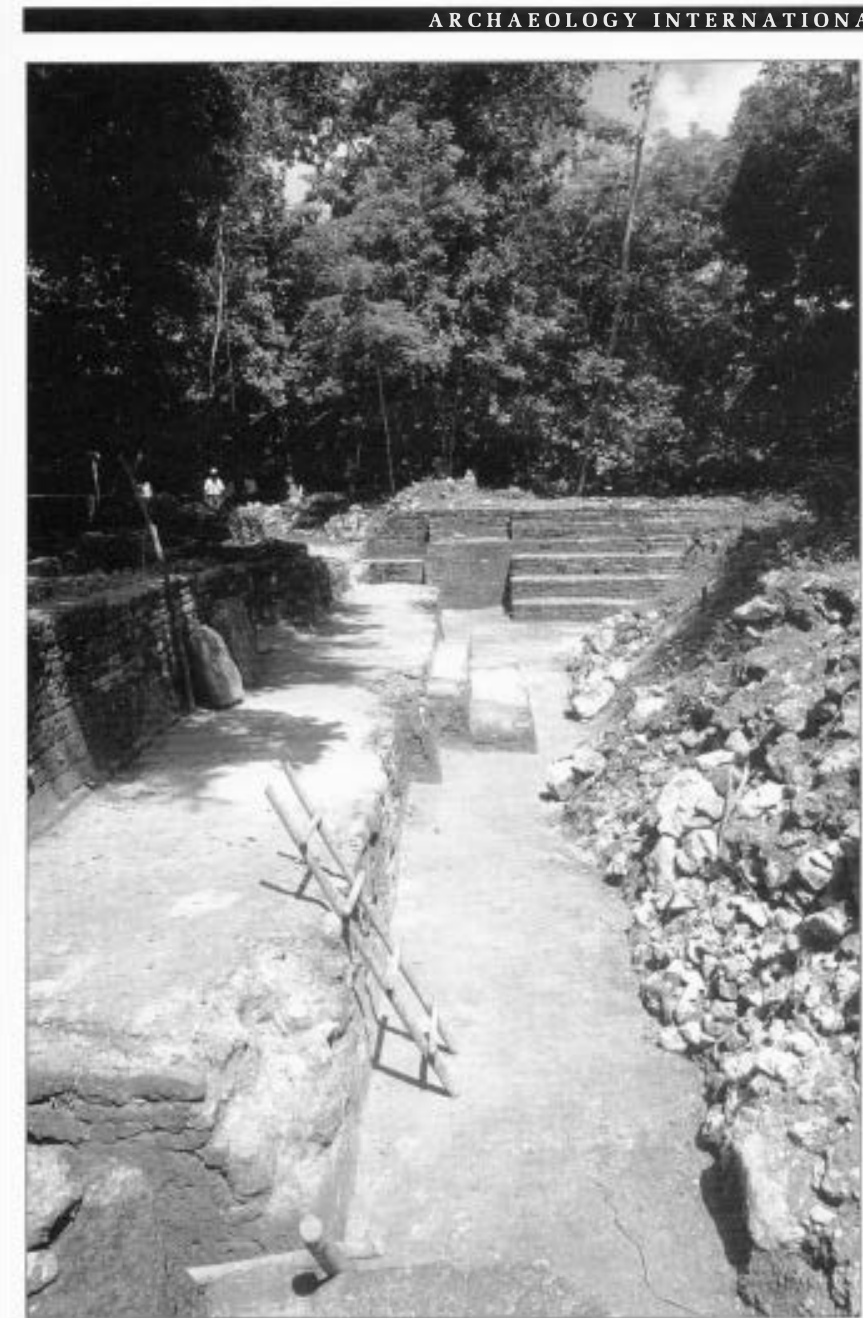
Figure 7 The courtyard of the Ottawa Group looking east. Structure Nl0-28 (see Fig. 4) is on the left. The ladder rests against the Nl 0-28 platform, and the partial-height walls of the building supported by the platform can be seen just above the ladder on the left. Some of the Boulders in fill has been removed to reveal the steps and platforms of N1 0-28 (left distance) and N10-17 (facingatthe far end); remaining in fill can be seen on the right. constructed on terraced platforms (some­ times mistakenly described as truncated pyramids), this infilling served to cover the faces of the platform terraces and